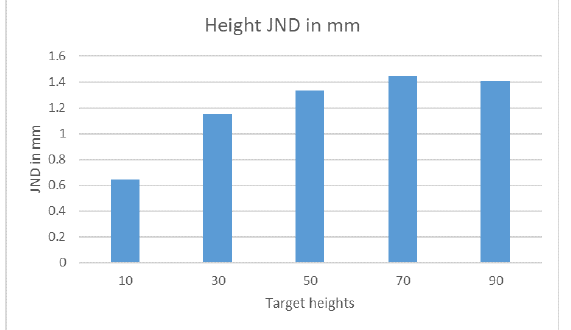
Figure 11. Just noticeable difference height in mm.